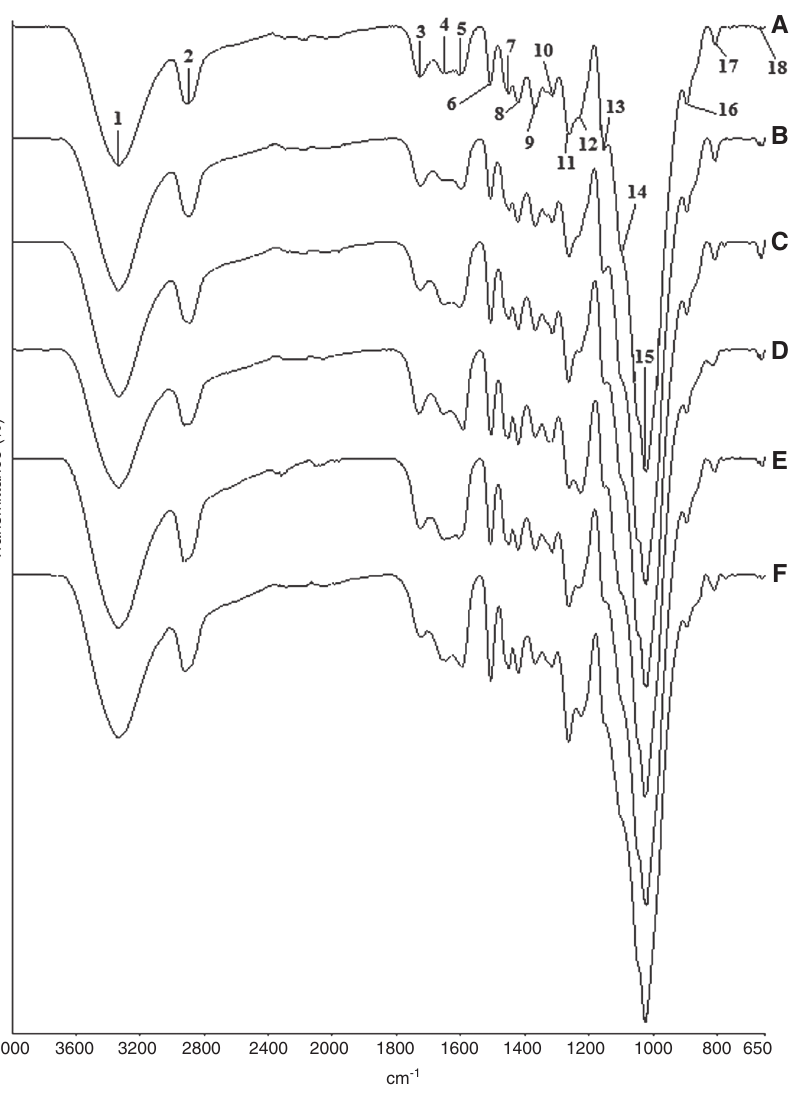
Figure 1 FT-IR spectral changes of Scots pine samples: (A) unaged samples, (B) aged samples, (C) unaged samples degraded by C. puteana , (D) aged samples degraded by C. puteana , (E) unaged samples degraded by P. placenta , and (F) aged samples degraded by P. placenta